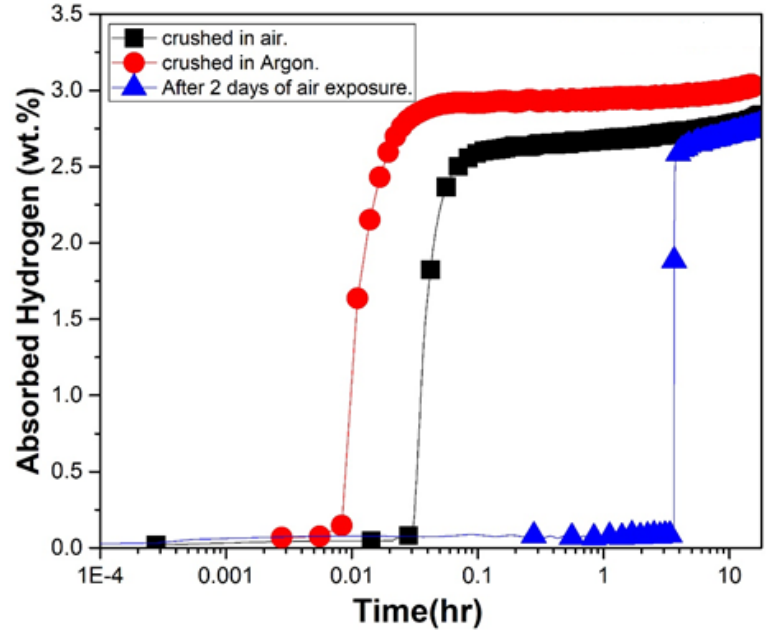
Figure 6. First hydrogenation curves of Ti 1 V 0.9 Cr 1.1 + 12 wt % Zr crushed under argon and under air and after two days of air exposure at room temperature and under 2MPa of hydrogen.